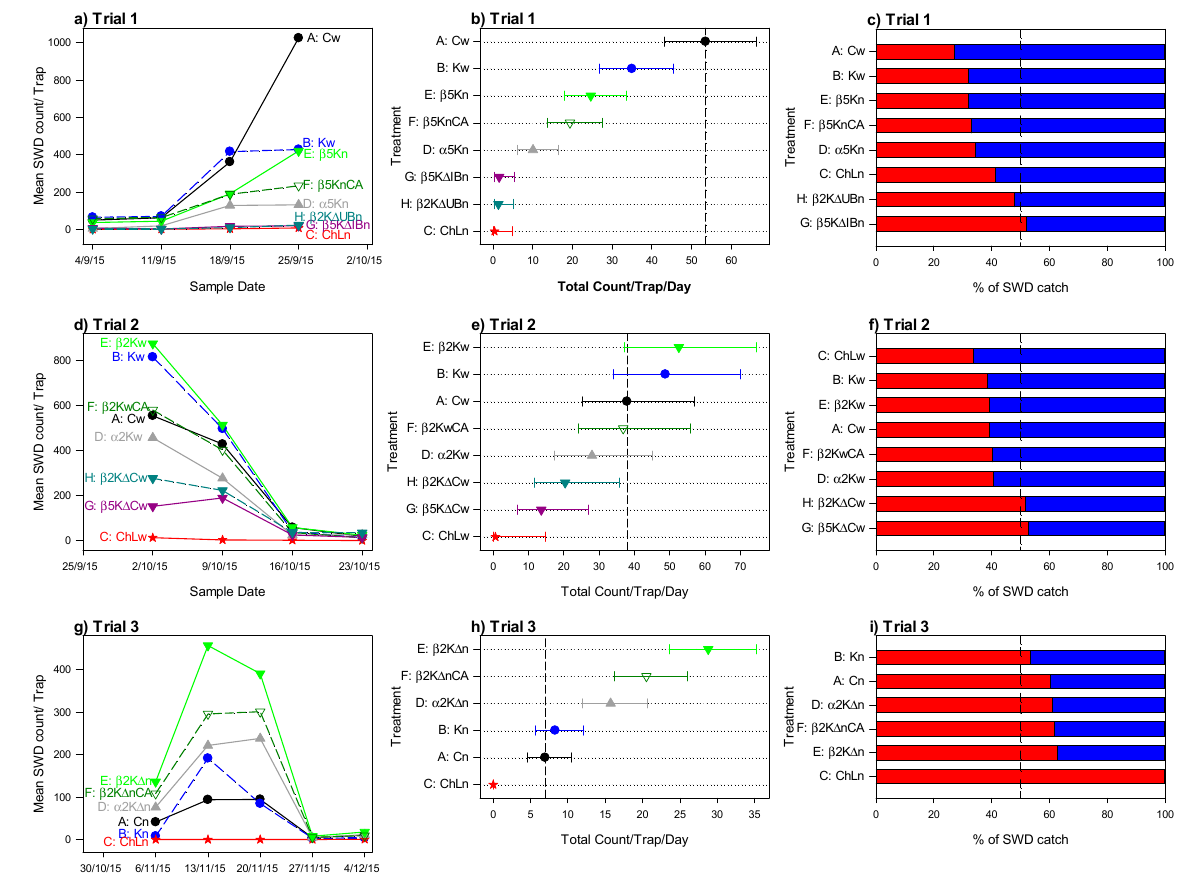
Figure 1. For each treatment in trials 1–3: Mean Drosophila suzukii (SWD) total catches per trap at each assessment ( a , d , g ); dot plots of mean total catch/trap/day with 95% confidence limits (as error bars), sorted by the means, with dotted vertical line at the mean for Treatment A (control) ( b , e , h ); and percentage of the total catch that was female (blue) or male (red) ( c , f , i ). Note that for h, the upper confidence limit for a mean of 0 is not shown as it is difficult to obtain. For a description of treatments, see Table 1: Traps are: C = cup with a lid; ∆ = delta trap; IB = insulated bottle; UB = uninsulated bottle. Delta traps without a bottle had a cup without a lid and supplied with two cotton balls. Liquid components are: K = KOH added; α = Alpha; β = Beta; 2 = rate 0.2; 5 = rate 0.5; CA = citric acid added. n = no liquid replacement; w = liquid replaced